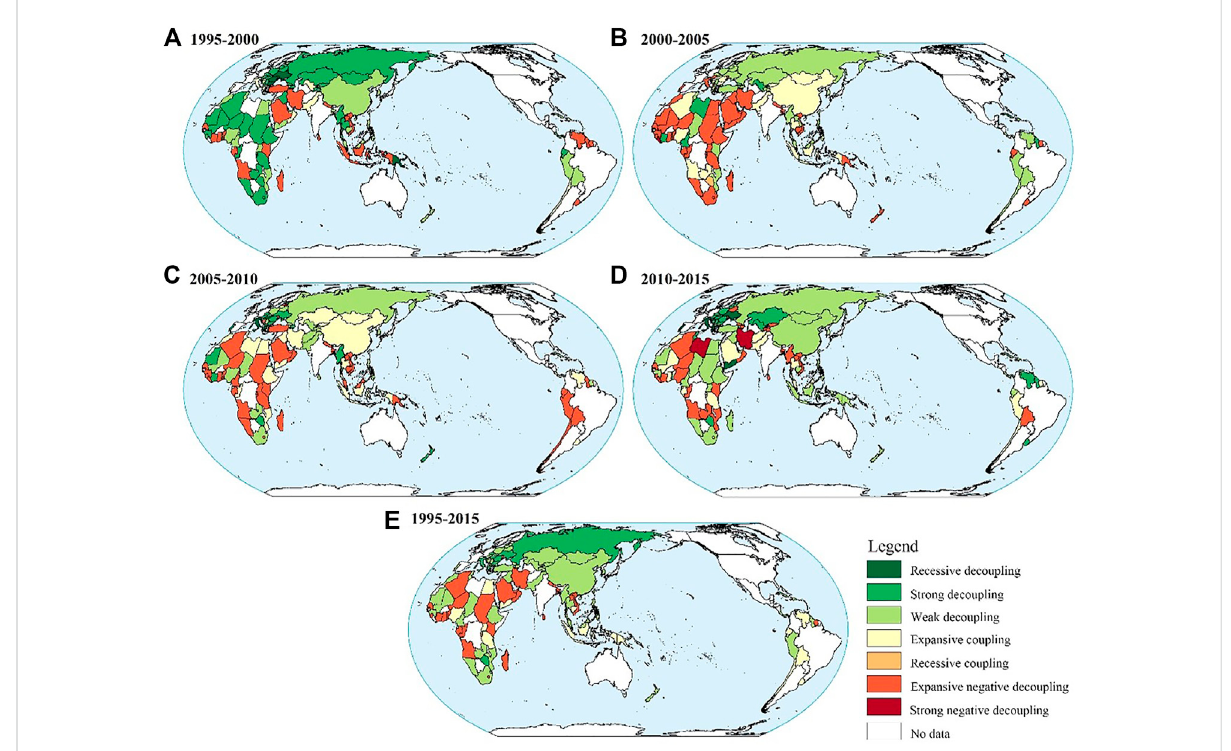
FIGURE 5 Consumption-based carbon emission decoupling statuses of the Belt and Road countries.